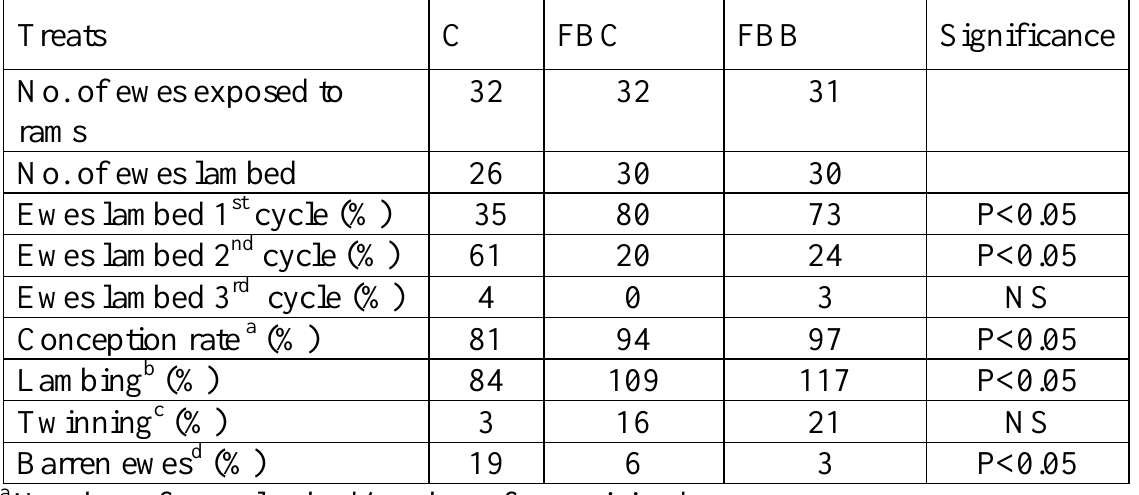
Table 4: Effect of feed block supplementation on reproductive performance of Awassi ewes grazing cereal stubble.